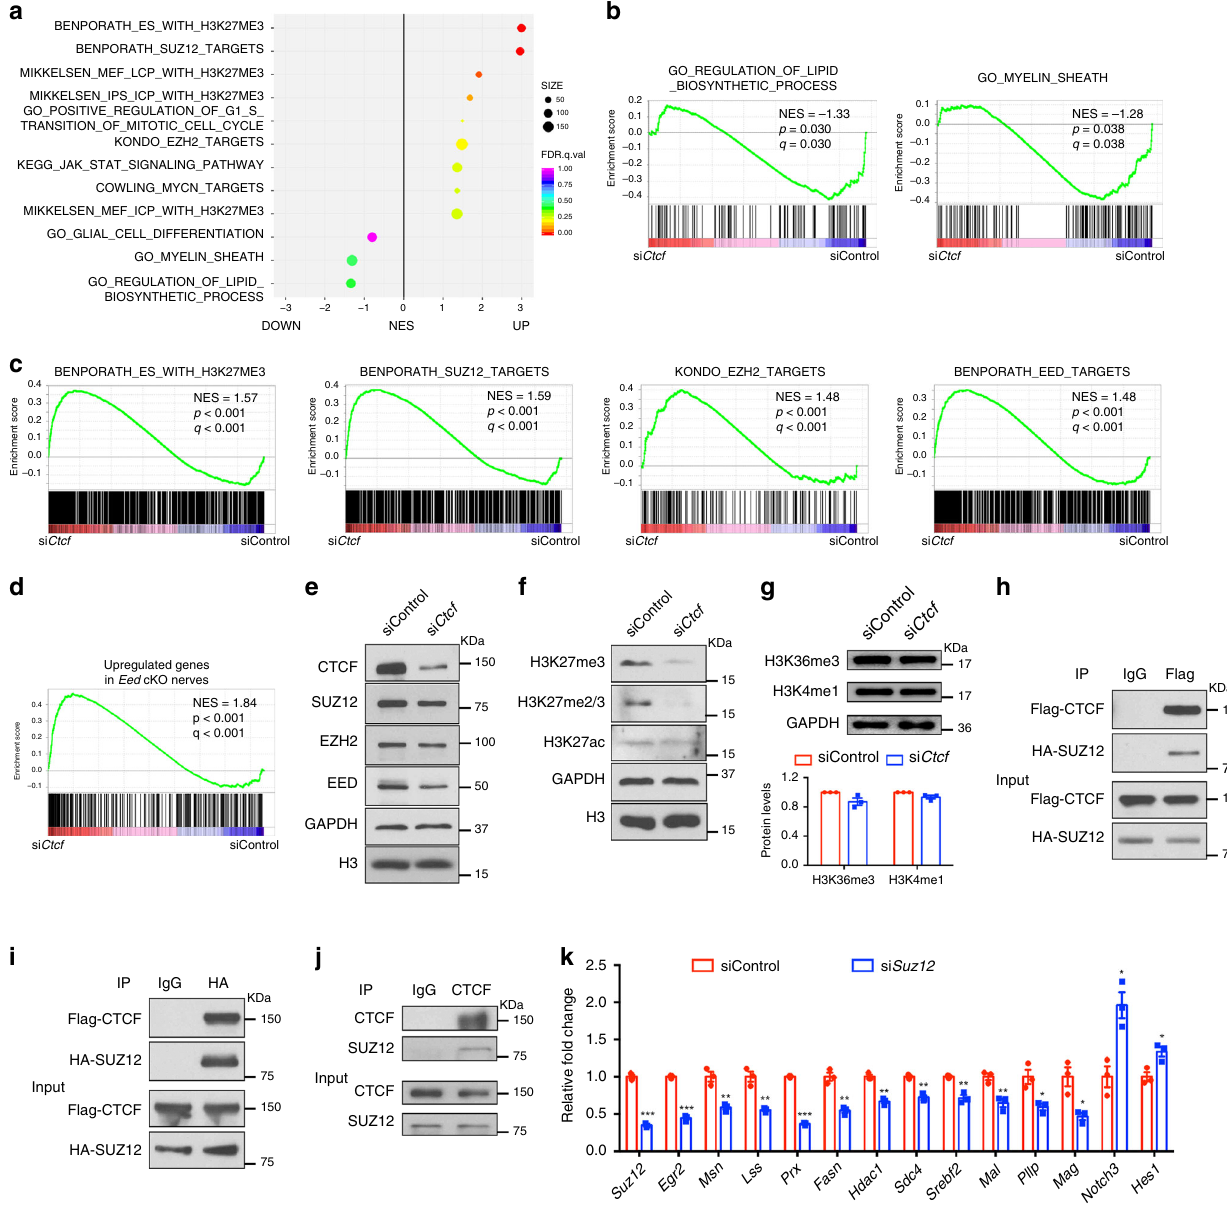
Fig. 8 CTCF cooperates with PRC2 complex to regulate SC differentiation. a GSEA enrichment scores for sets of genes differentially regulated in rat SCs treated with si Ctcf or control siRNA. n = 3 independent experiments. b GSEA enrichment scores for genes involved in lipid biosynthetic process (left) and myelin sheath (right) in SCs treated with control or si Ctcf . c GSEA enrichment scores for genes modi fi ed with H3K27me3 and for genes targeted by SUZ12, EZH2, or EED in SCs treated with control or si Ctcf . d GSEA enrichment scores for genes upregulated genes in Eed cKO nerves from published data 37 . NES, normalized enrichment score. e – g Immunoblotting for e PRC2 complex and CTCF proteins and for f , g histones with indicated modi fi cations in SCs treated with control or si Ctcf . e , f n = 2 independent experiments; g n = 3 independent experiments. h – j Co-immunoprecipitation of h , i HA-SUZ12 with Flag-CTCF from extracts of transiently transfected HEK293T cells or of j endogenous SUZ12 with CTCF from rat SCs. n = 2 independent experiments. k qRT-PCR analysis showing Suz12 and differentiation-related and myelin-related gene expression in rat SCs transfected with control siRNA or with Suz12 -targeted siRNA ( n = 3 independent experiments) and induced to differentiate for 9 h. Data are presented as means ± SEM., *** P < 0.001, ** P < 0.01, * P < 0.05; two- tailed unpaired Student ’ s t -test, P ( Suz12 ) = 3.8E-05, P ( Egr2 ) = 3.3E-05, P ( Msn ) = 0.0045, P ( Lss ) = 0.0031, P ( Prx ) = 1.5E-06, P ( Fasn ) = 0.0019, P ( Hdac1 ) = 0.0019, P ( Sdc4 ) = 0.0015, P ( Srebf2 ) = 0.0026, P ( Mal ) = 0.008, P ( Pllp ) = 0.018, P ( Mag ) = 0.017, P ( Notch3 ) = 0.012, P ( Hes1 ) = 0.02. Source data are provided as a Source Data fi